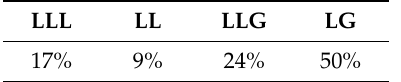
Figure 5. Single line diagram of Finnish distribution network under study. Table 1. Share of di ff erent fault types in the network under study.